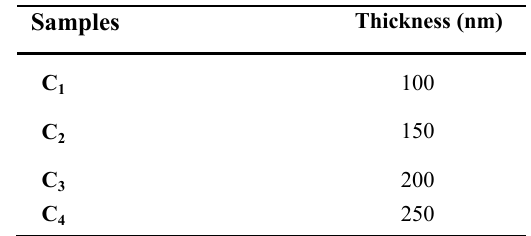
Fig. 1. Example of RBS spectrum for tellurium film. Table 1. Thickness of Te films that measured by RBS